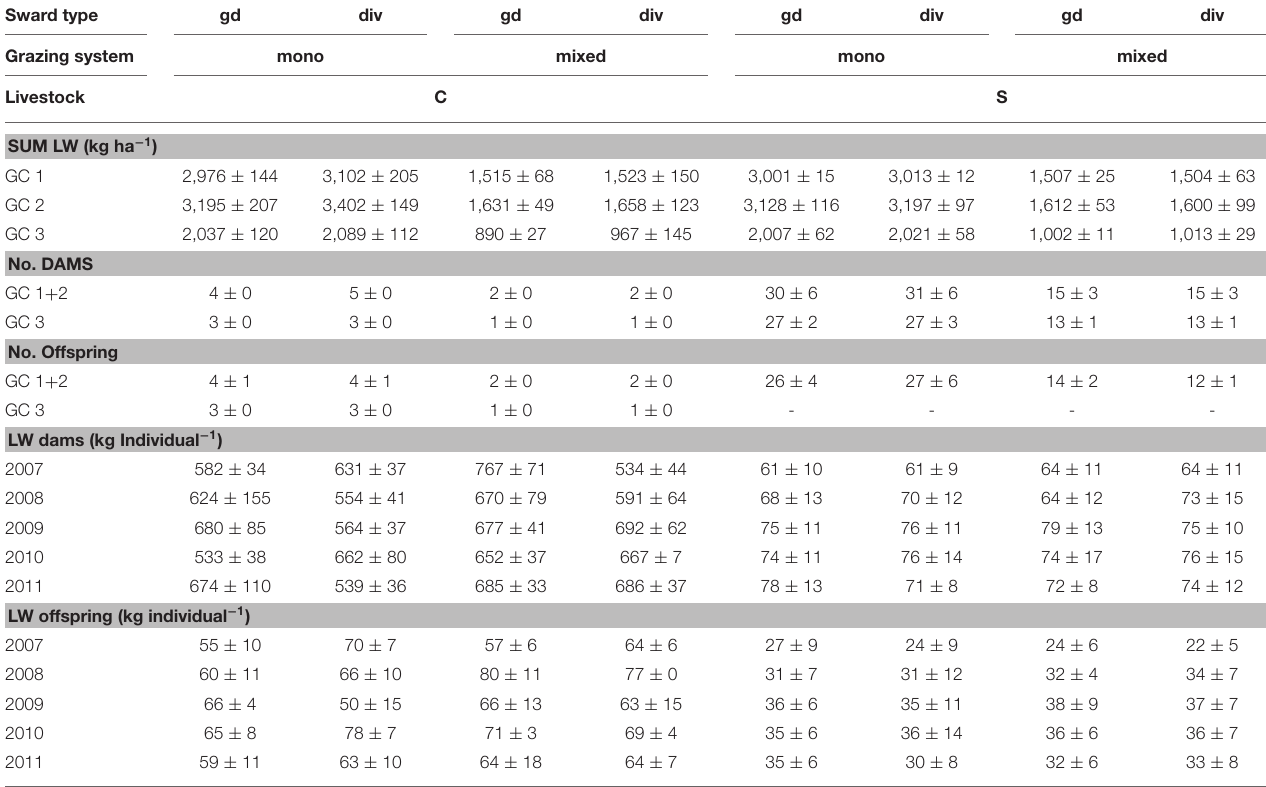
TABLE 3 | Livestock characteristics during the grazing seasons 2007 until 2011 as affected by sward-type, grazing system and gracing cycle (GC) for each livestock species. Sward type gd div gd div gd gd div Grazing system mono mixed mono mixed